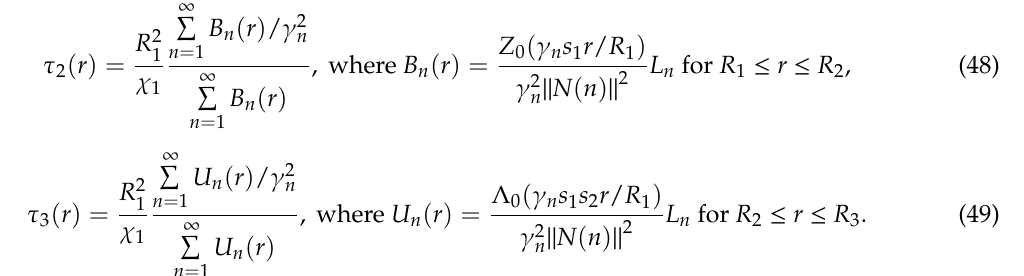
Figure 4. Relative difference (44) of temperature increases determined by means of the Green’s and finite element methods for ),( MM ρα parameters.